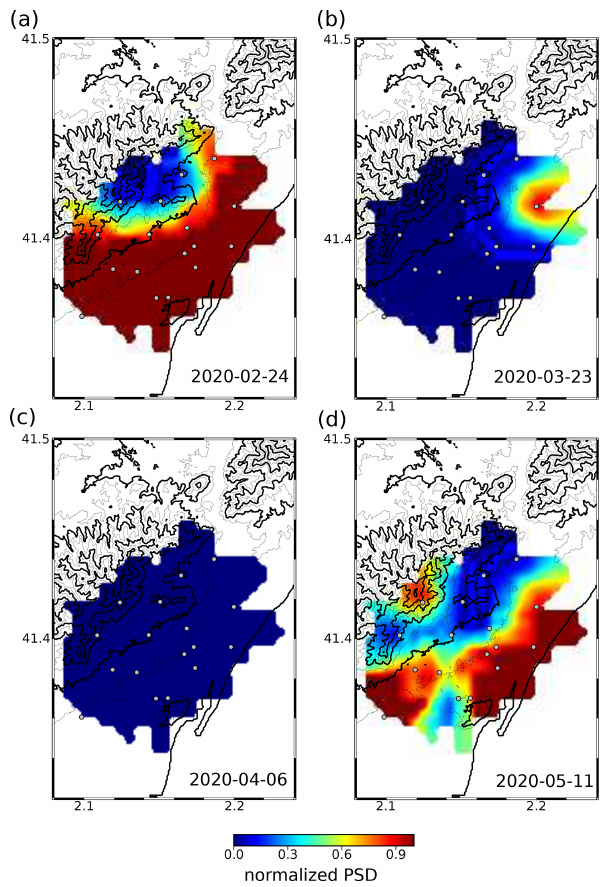
Figure 6. Daily maps representing the normalized power in the 2– 20Hz band during working hours. Each image corresponds to a Monday (Fig. S2 shows all the daily snapshots). (a) Pre-lockdown period. (b) Lockdown phase 1. (c) Lockdown phase 2. (d) Lifting period. Topographic contours are included for reference (thick lines: 100m interval; thin lines: 50m